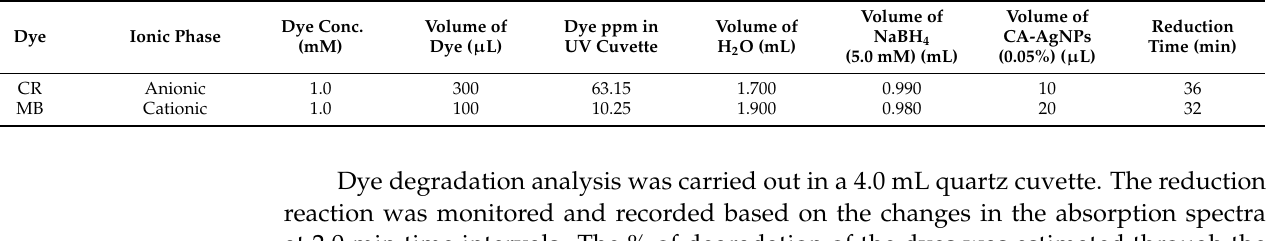
Table 1. Experimental proportions set for dye degradation test.